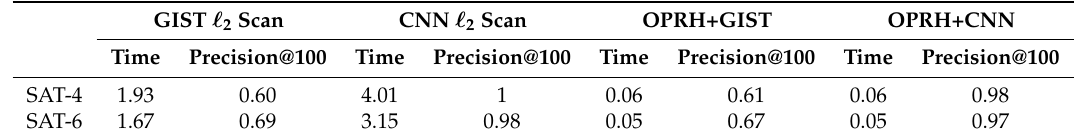
Table 4. The comparison of average search time (in seconds) and accuracy (mean precision of Top-100 retrieved samples) between our proposed hashing method in the hamming space (with 64-bits) and (cid:96) 2 linear scan in the original feature space based on different feature